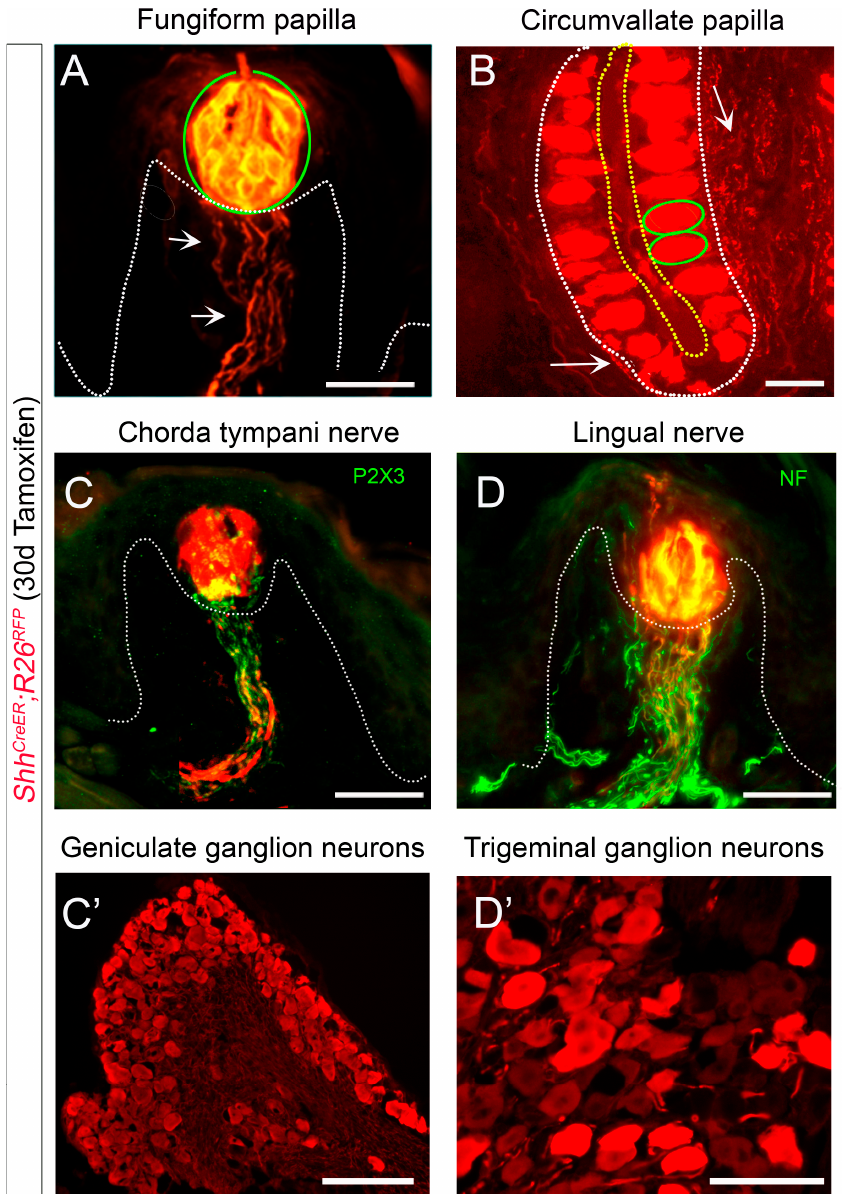
Figure 3. SHH expression in lingual papilla taste buds, nerves, and ganglia. ( A – D’ ). RFP (red) expression after 30 days of tamoxifen administration in Shh CreER ;R26 RFP mice. ( A , B ). In both the anterior tongue fungiform ( A ) and posterior circumvallate ( B ) papillae, taste buds include Shh + cells and their progeny (green oval outlines), while the connective tissue core includes Shh + nerve fibers (white arrows). ( C – D’ ). Chorda tympani nerve fibers (( C ), P2X3+, green) and cell bodies in the geniculate ganglion ( C’ ) are Shh +. Although all lingual nerve fibers (( D ), NF+, green) do not express Shh , cell bodies in the trigeminal ganglion ( D’ ) are Shh +. White dotted lines demarcate the basal lamina in subfigures ( A – D ). Yellow dotted line marks the apical taste buds regions in the papilla cleft in subfigure ( B ). Scale bar: 50 µ m, applies to all